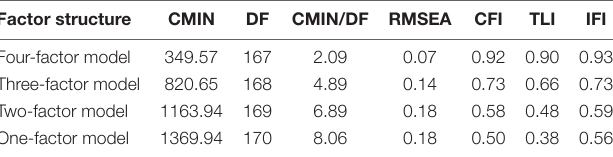
TABLE 1 | Confirmatory factor analysis for discriminant